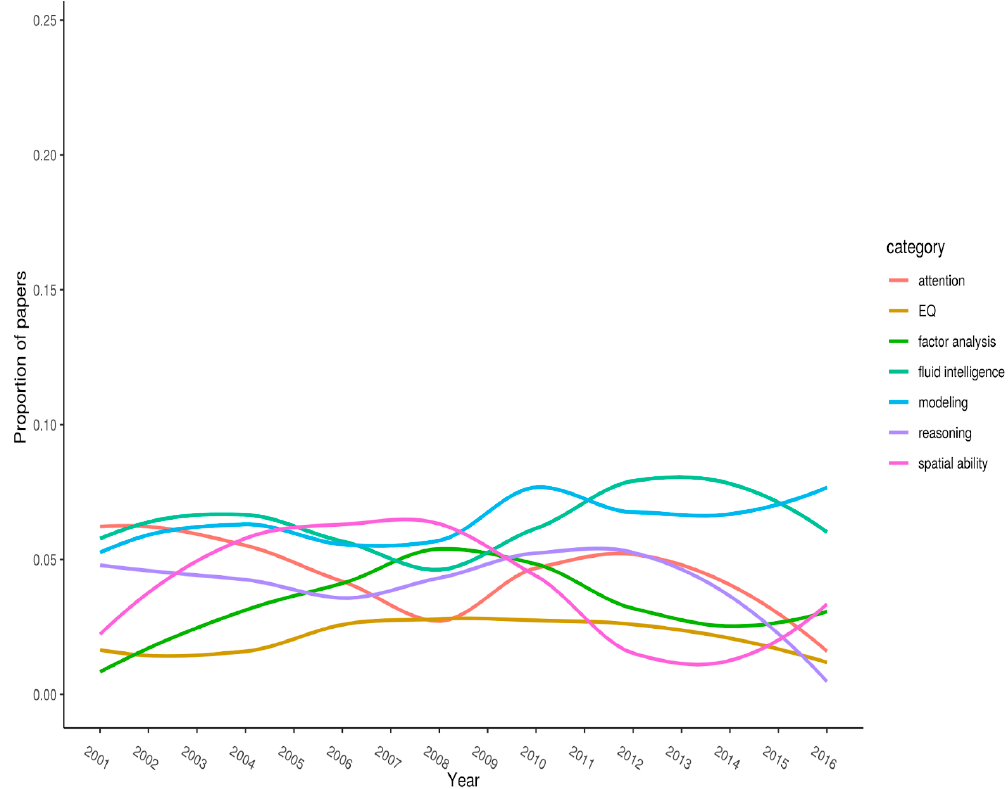
Figure 1. Proportion of articles each year that list a given keyword (flat).